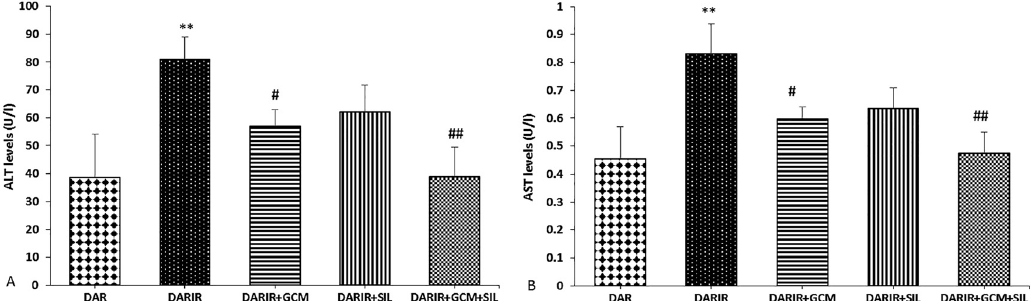
Figure1: Plasmalevelsofhepaticenzymes.(A)ALT:alanineaminotransferase;(B)AST:aspartateaminotransferase.Thedatawereexpressed as mean ± SD. N=6 for each group. ** p<0.01 as compared with DAR group; # p<0.05 and ## p<0.01 as compared with DARIR group. DAR, diabetic aged rat; DARIR, diabetic aged rat subjected to ischemia-reperfusion; GCM, ginsenoside compound-Mc1; SIL, silibinin.